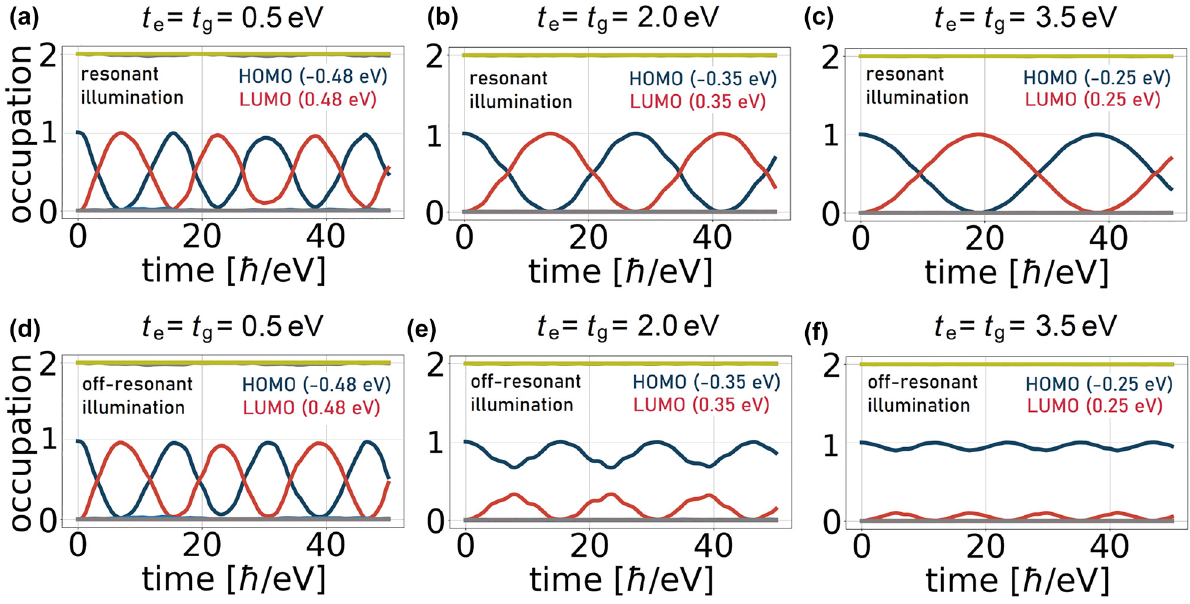
Figure 8: Occupation dynamics with evident Rabi oscillations between the HOMO and LUMO states in the 18-atom flake with an adatom. Here, the Coulomb interaction is not included. In the ‘‘resonant illumination’’ case (a–c), the illumination frequency is always resonant to the HOMO–LUMO transition frequency. In the ‘‘off-resonant illumination’’ case (d–f), the illumination frequency is fixed and equal to 1 eV in each